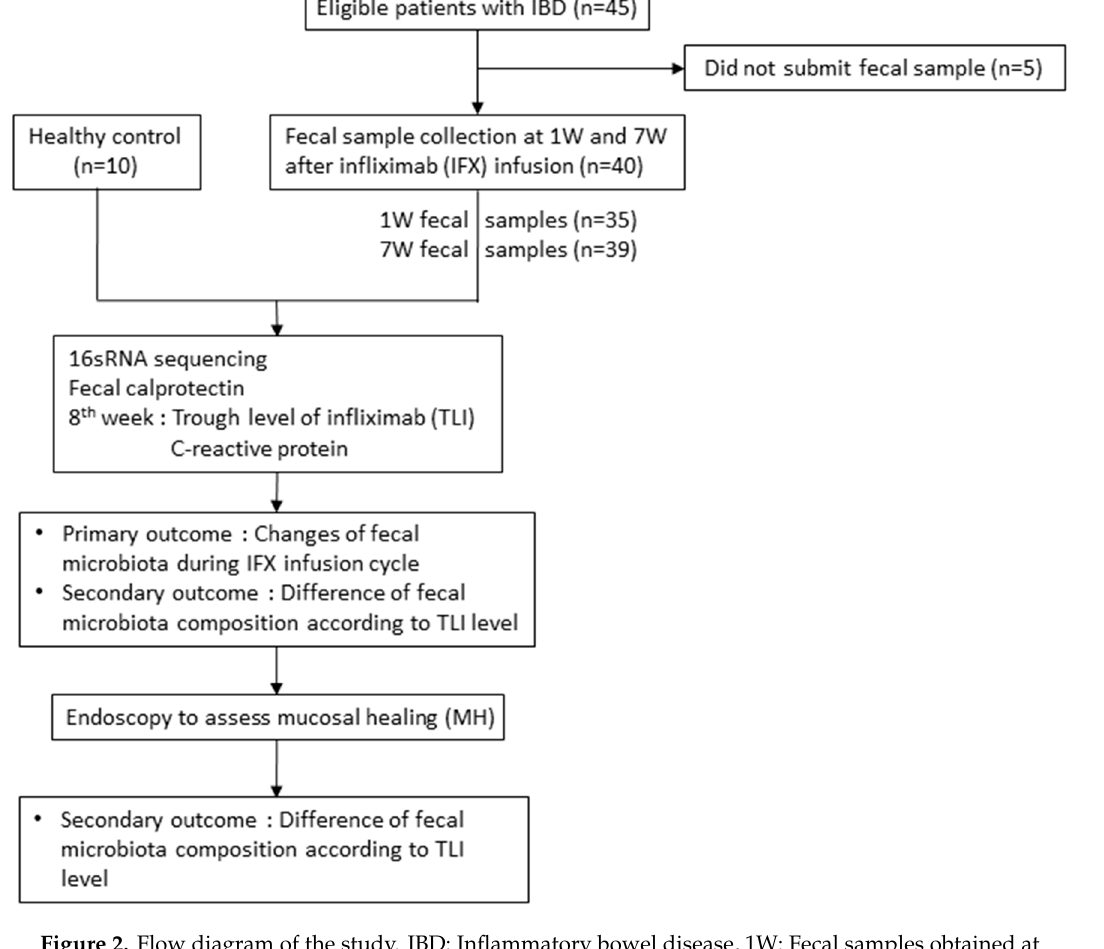
Figure 2. Flow diagram of the study. IBD: Inflammatory bowel disease, 1W: Fecal samples obtained at 1-2 weeks after infliximab infusion, 7W: Fecal samples obtained at 7-8 weeks after infliximab